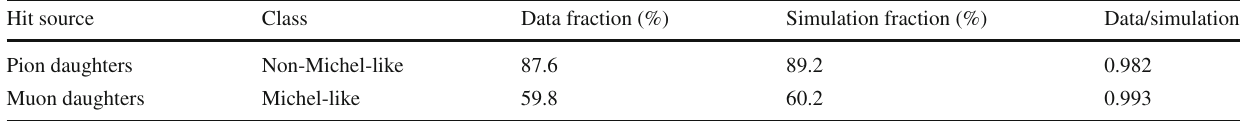
Table 5 Fraction of daughter hits classified into appropriate class for different samples in ProtoDUNE-SP data and simulation. The statistical uncertainties on the fractions and ratios are negligible